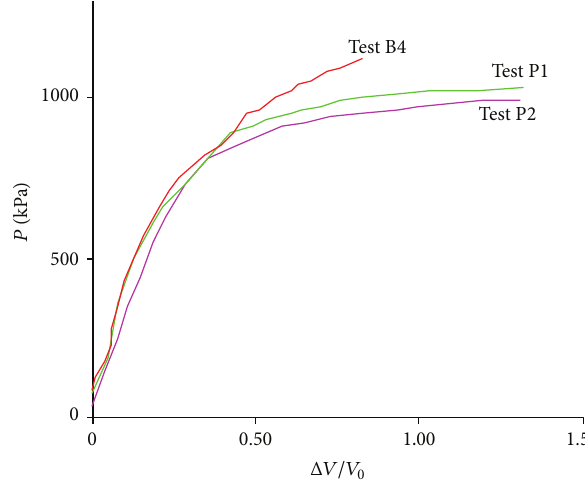
Figure 1: Pressuremeter curves at a depth of 2m after being modi- fied by lift-off method.